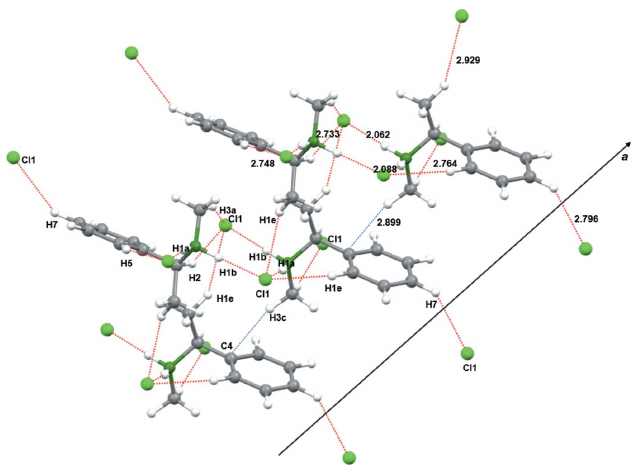
Figure 2 A view along the a -axis direction of the crystal packing of compound 1 . Selected hydrogen-bond lengths (in A˚ ) are indicated.